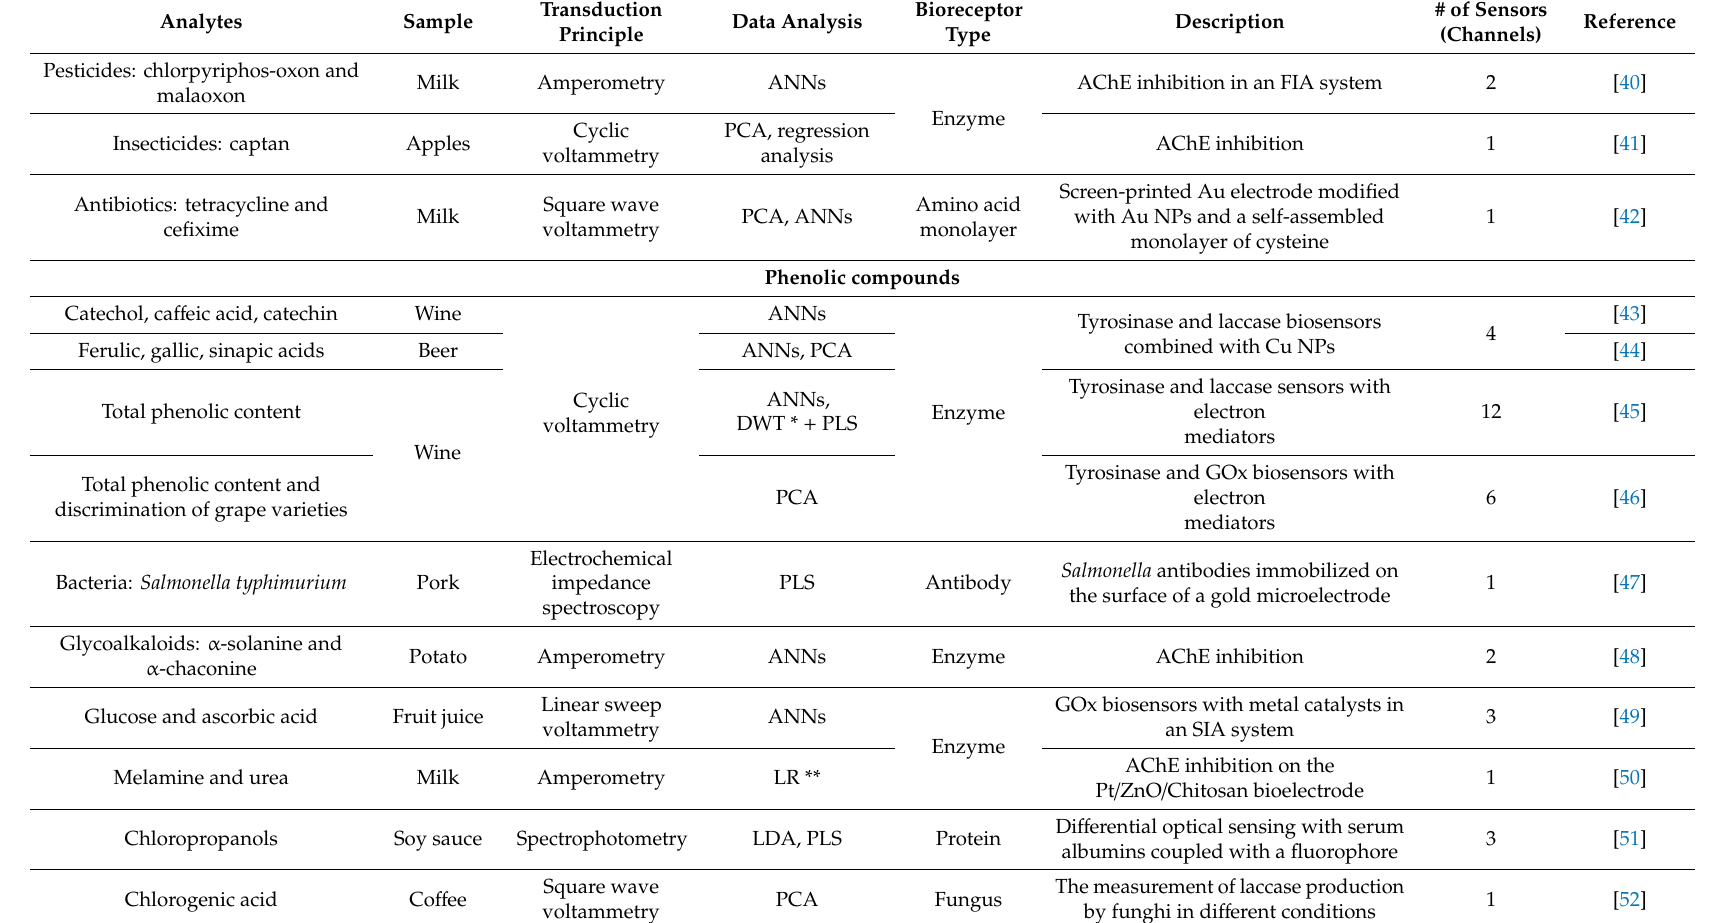
Table 2. Examples of biosensors and biosensor ETs for the food and beverages